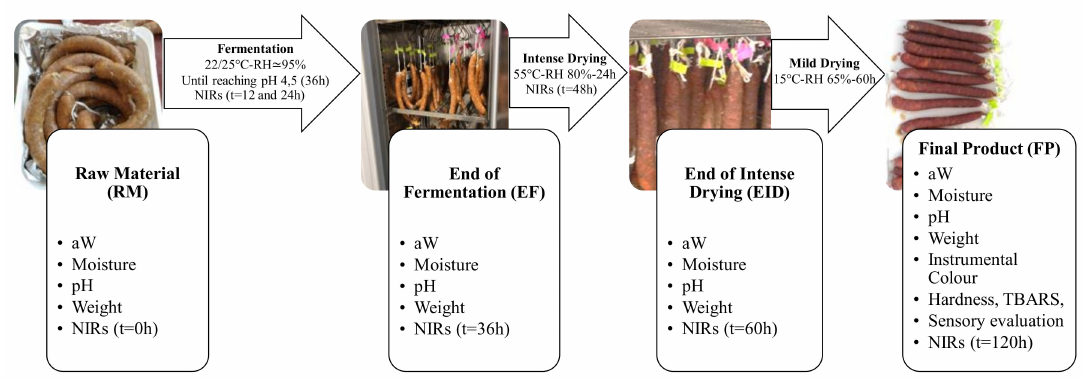
Figure 1. Scheme of the dry fermented sausage ripening process and analyses carried out at each stage. RH, relative humidity; aW, water activity; TBARS, thiobarbituric acid-reactive substances; NIRs, near infrared